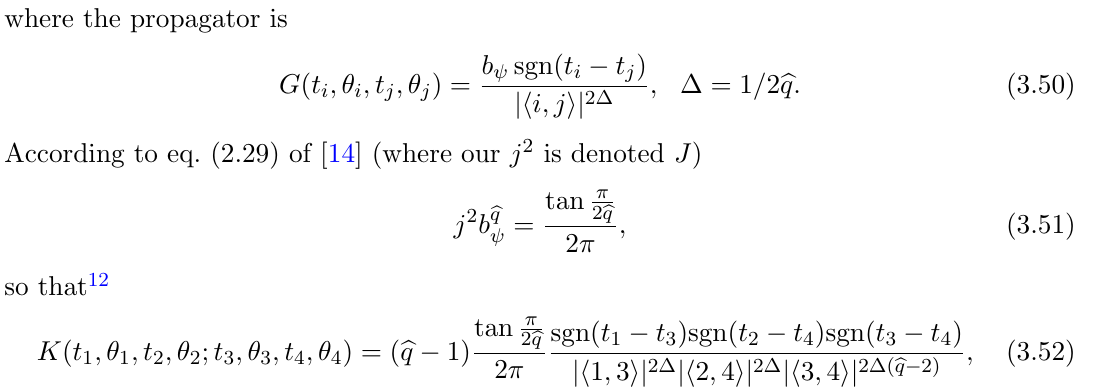
Figure 1 . A kernel describing propagation of a two-particle system from t 3 ; (cid:18) 3 and t 4 ; (cid:18) 4 to t 1 ; (cid:18) 1 and t 2 ; (cid:18) 2 . For the case of a b q -fold interaction in superspace, points 3 and 4 are connected by b q propagators, as here for the case b q =